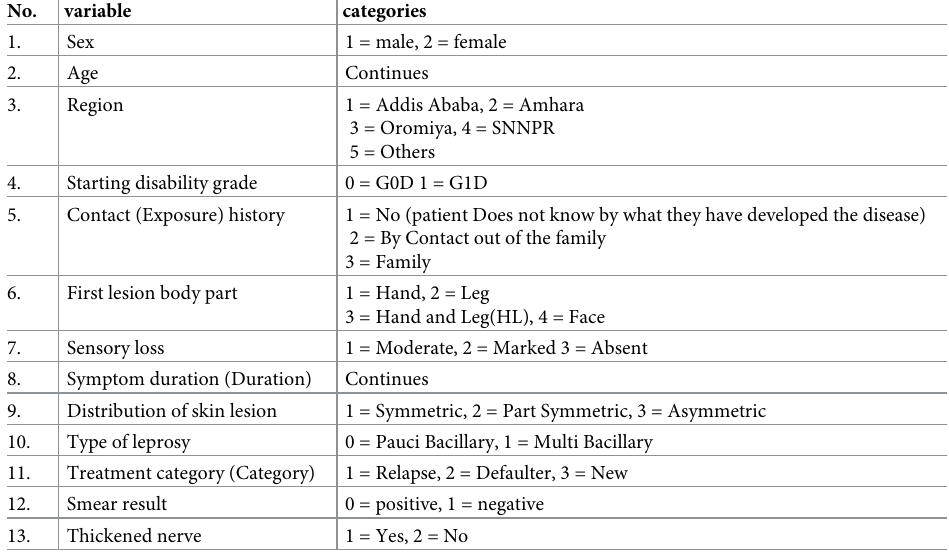
Table 1. Depiction of covariates that were incorporated for the